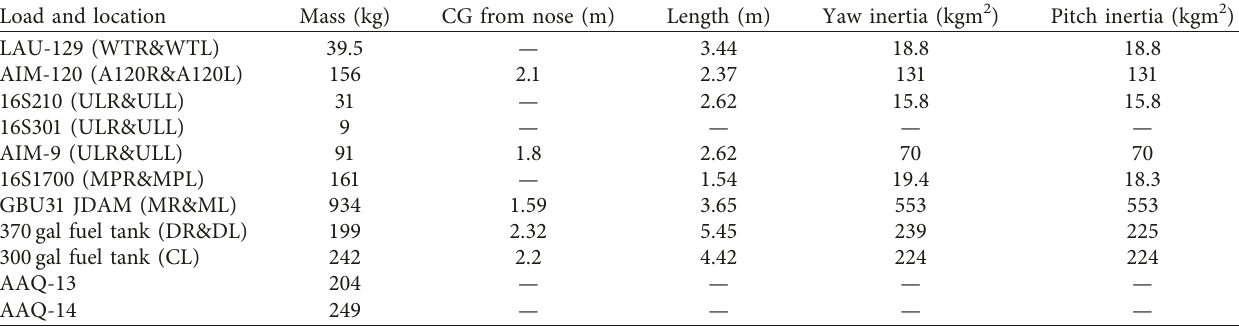
Table 8: Loads and locations.